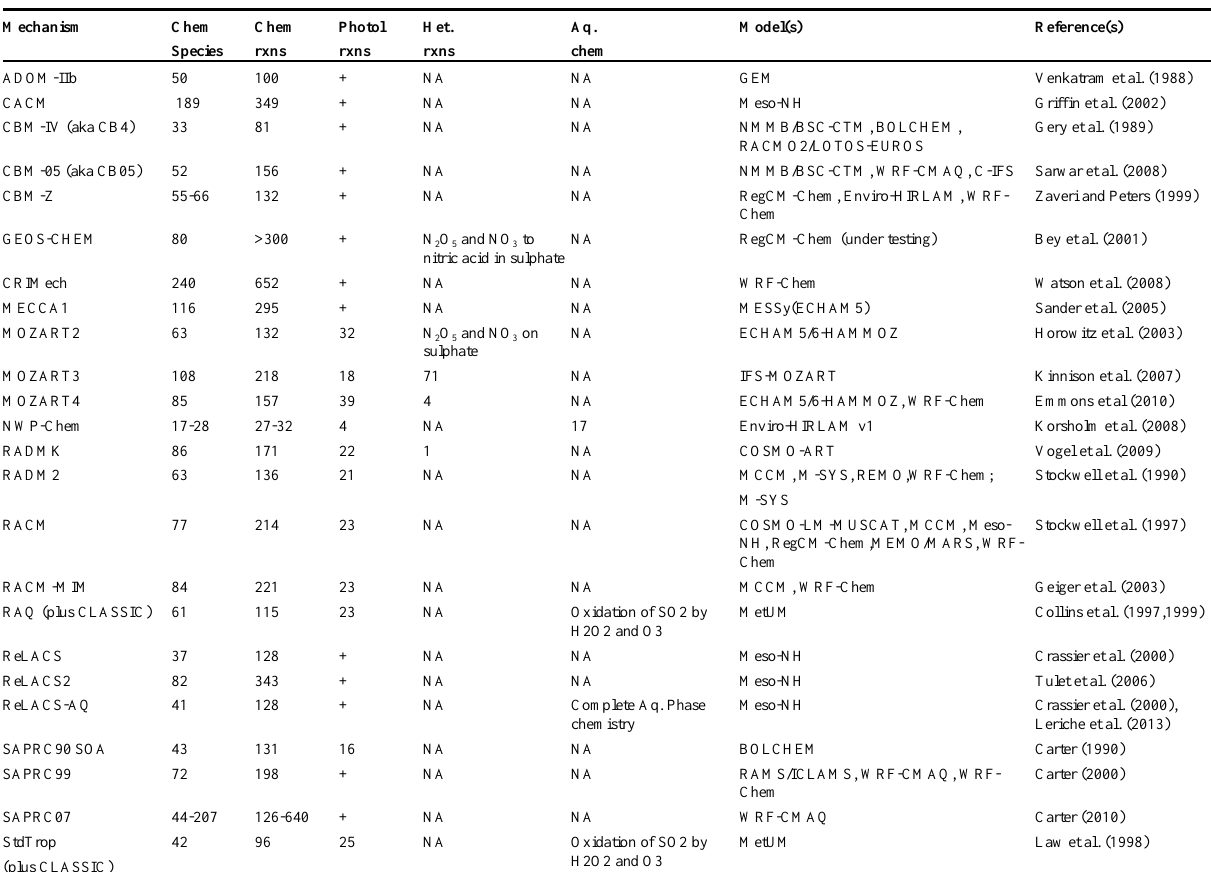
Table 6. Comparison of chemical mechanisms used in coupled models. In the photolysis rate column, “+” means documentation available does not separately list the photolysis reactions and so they are included in the chemical reactions. NA means the available documentation either did not include the relevant data or that the mechanism does not include any heterogeneous reactions. Note that most of these mechanisms are explicitly gas phase chemistry mechanisms – the models in which they are implemented may include in addition aqueous phase chemistry.